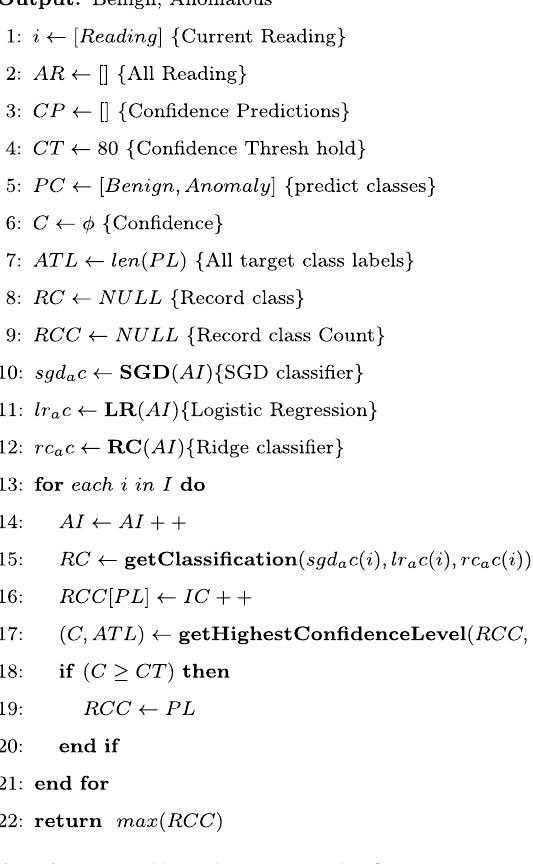
Algorithm 1 Ensemble Machine Learning